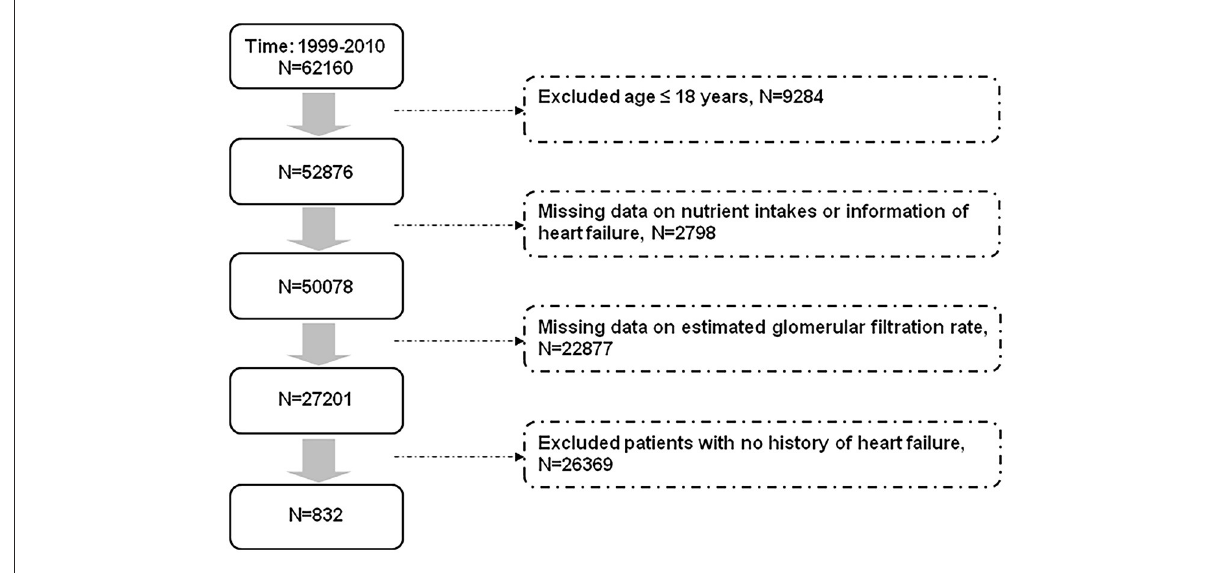
FIGURE1 Flow diagram displaying the selection of study population.